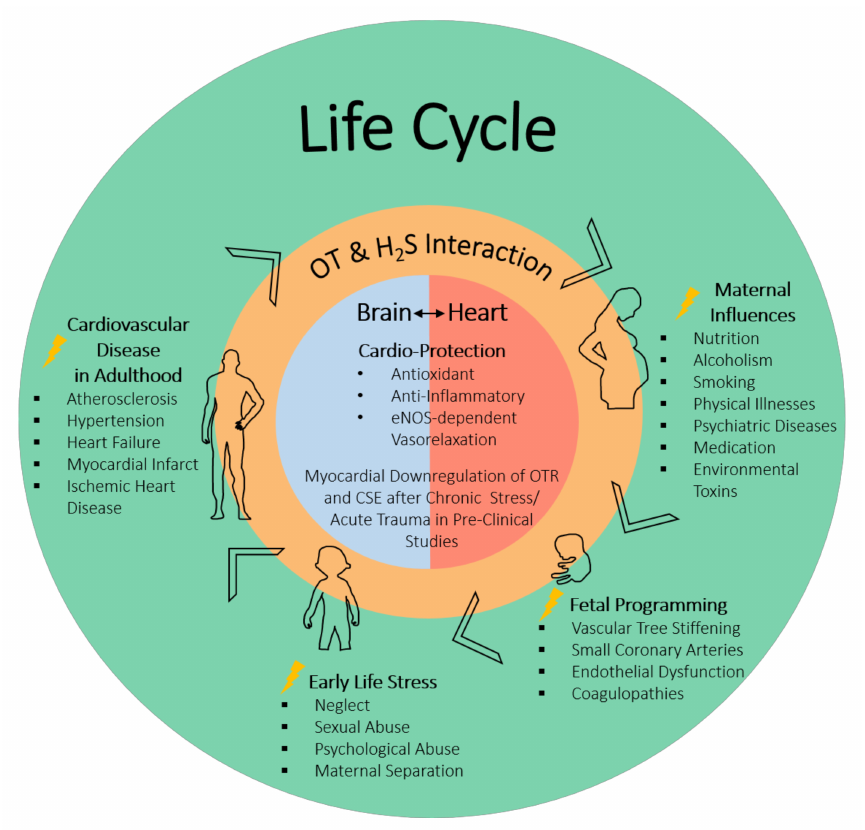
Figure 1. Interaction of OT and H 2 S in the brain and the heart: contribution to physical manifes- tation/protection of ELS-induced CVD in adulthood. ELS affects cardio-vascular programming and the development of CVD in adulthood. Pregnant women who experienced ELS may pass on ELS-triggered behavior/physical conditions: nutrition, smoking, alcoholism, medication/drugs, and illness. Long-term effects on the cardiovascular system of the fetus can be morphological and func- tional adaptations, stiffening of the vascular tree, small coronary arteries, endothelial dysfunction, reduced number of cardiomyocytes, atherogenic blood lipid profiles, and coagulopathies. Bringing together literature reports on OT and H 2 S suggests that both are significant common mediators of cardio-protective effects during development as well as in adulthood through their antioxidant and anti-inflammatory effects and eNOS-dependent vasorelaxation. Pre-clinical studies suggest that chronic stress and/or acute trauma leads to a downregulation of the OTR and CSE (the main endogenous H 2 S-producing enzyme in the vasculature). OT: oxytocin; H 2 S: hydrogen